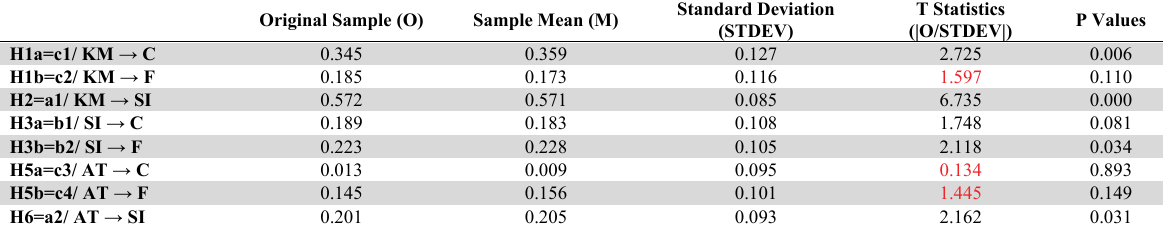
The results of statistical